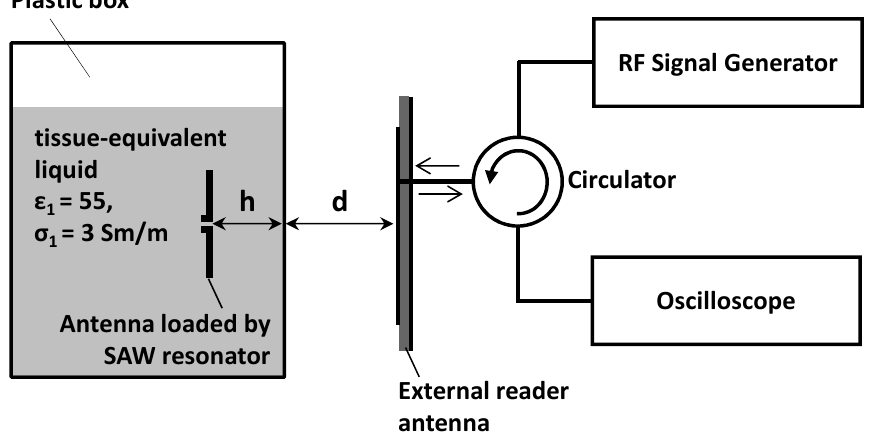
Figure 4. The scheme of the experimental setup for measurement of the transmission coefficient of the wave propagating through the interface.